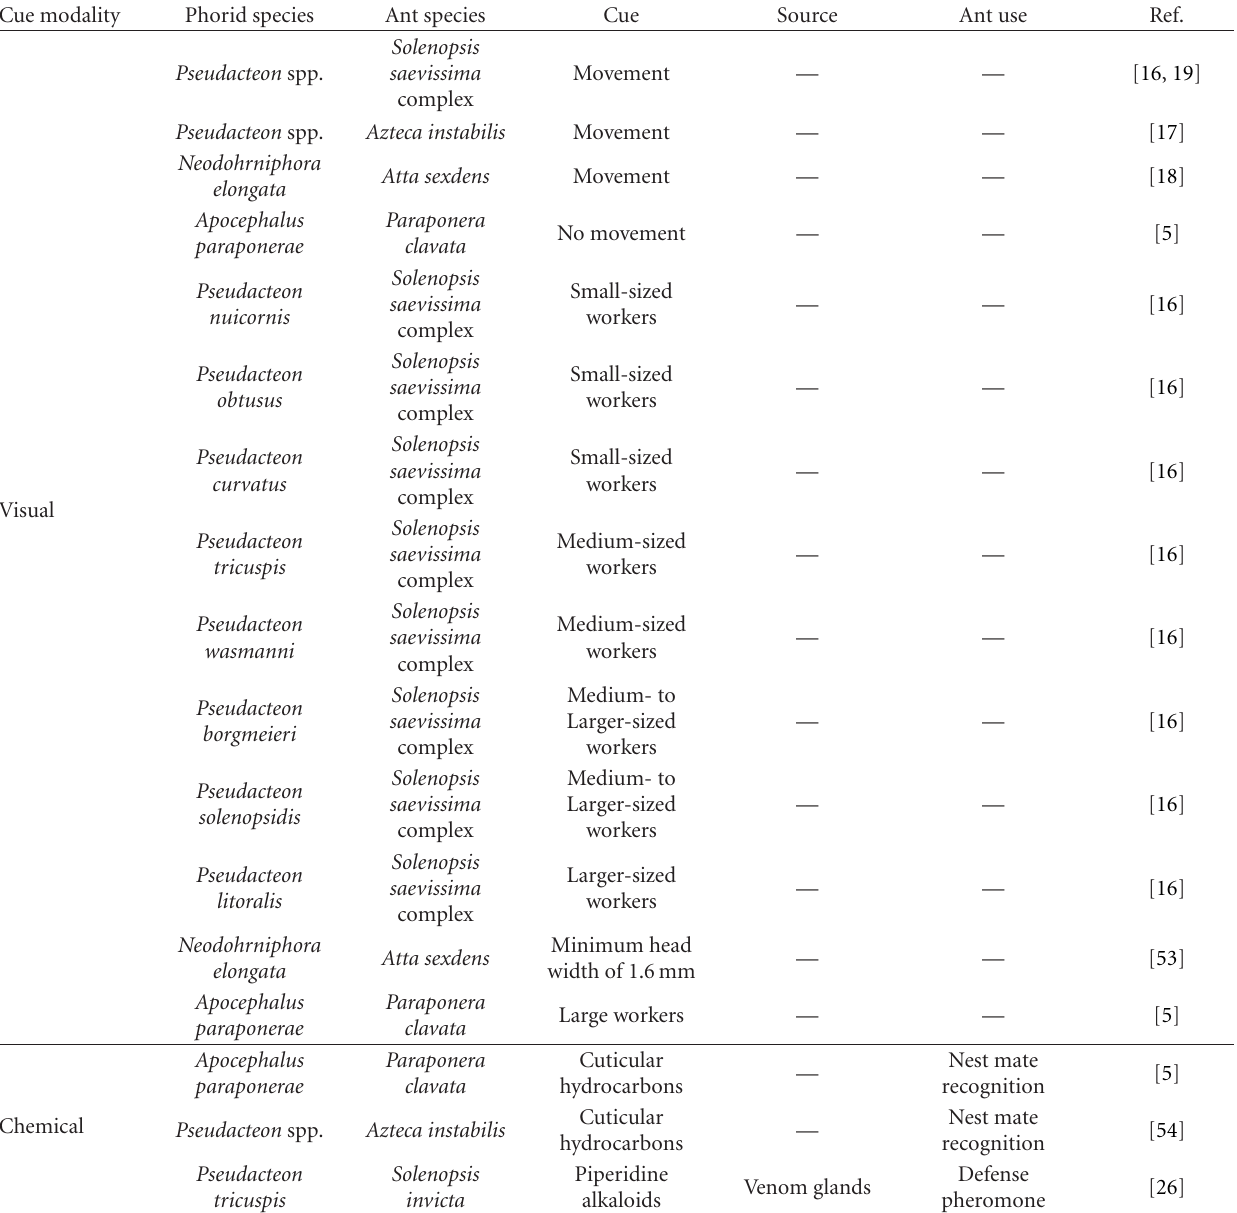
Table 2: Host acceptance cues used by phorid flies to choose ant